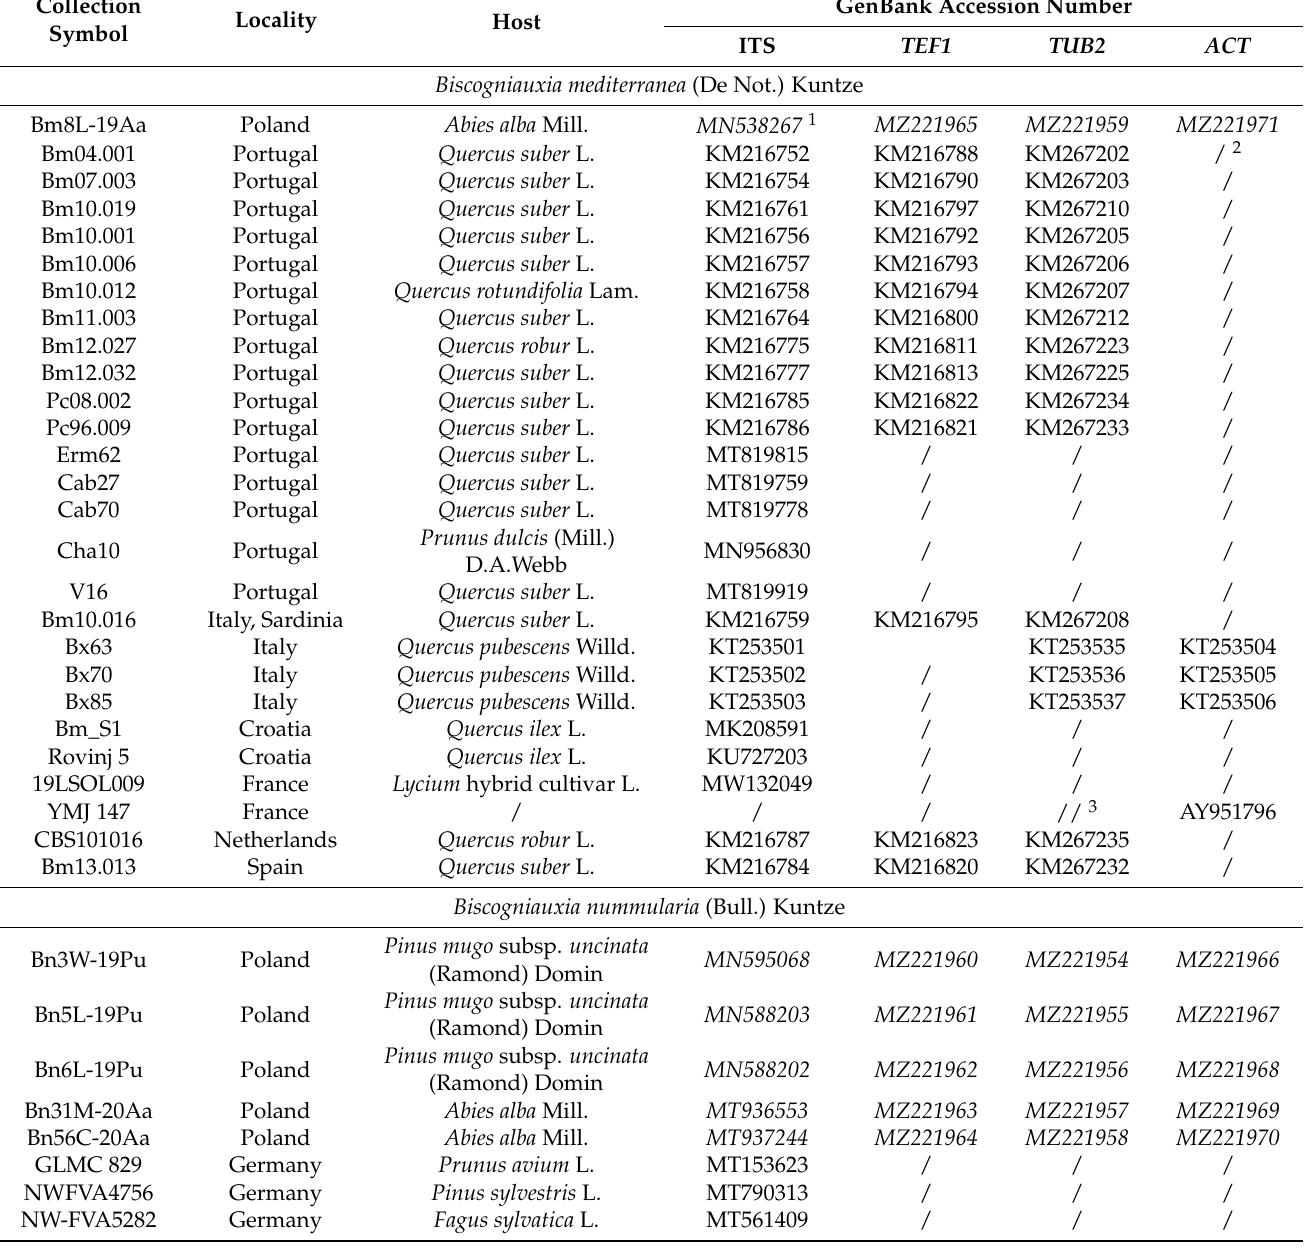
Table 3. Details of Biscogniauxia spp. isolates used in the molecular